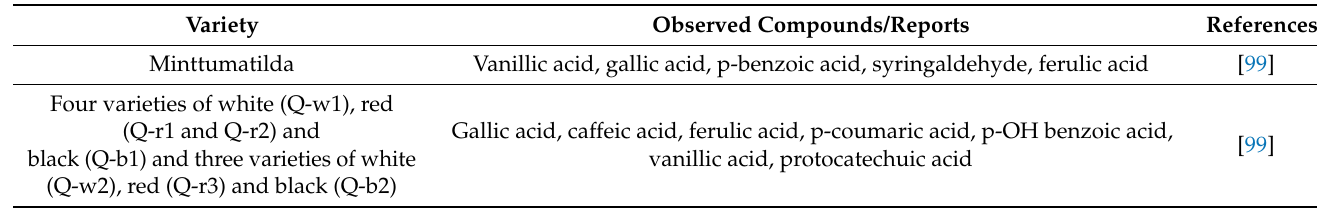
Table 3. Secondary metabolites identified from different quinoa varieties.